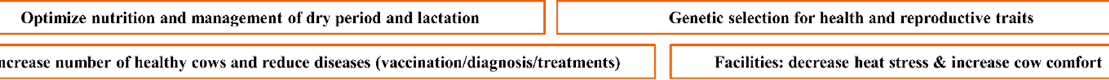
Figure 7. Concluding figure on how to increase the number of cows entering “the high fertility cycle”, including physiological aspects, reproductive management strategies, and factors that impact reproductive performance. Body condition score (BCS), voluntary waiting period (VWP), timed AI (TAI), nonpregnancy diagnosis (NPD), days in milk (DIM), and pregnancy per AI (P/AI).